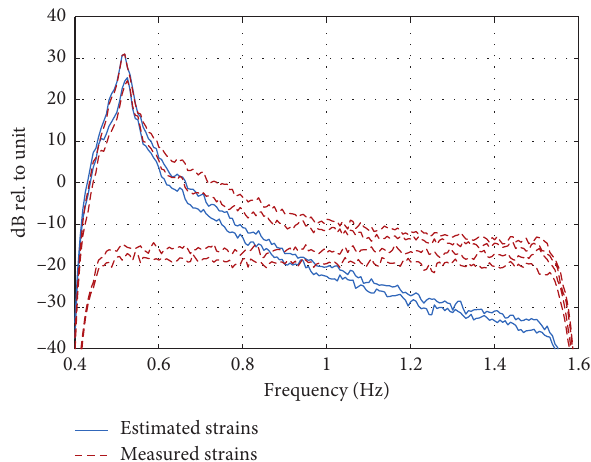
Figure 7: Spectrum plot of estimated and measured strains at Elevation 1 for dataset